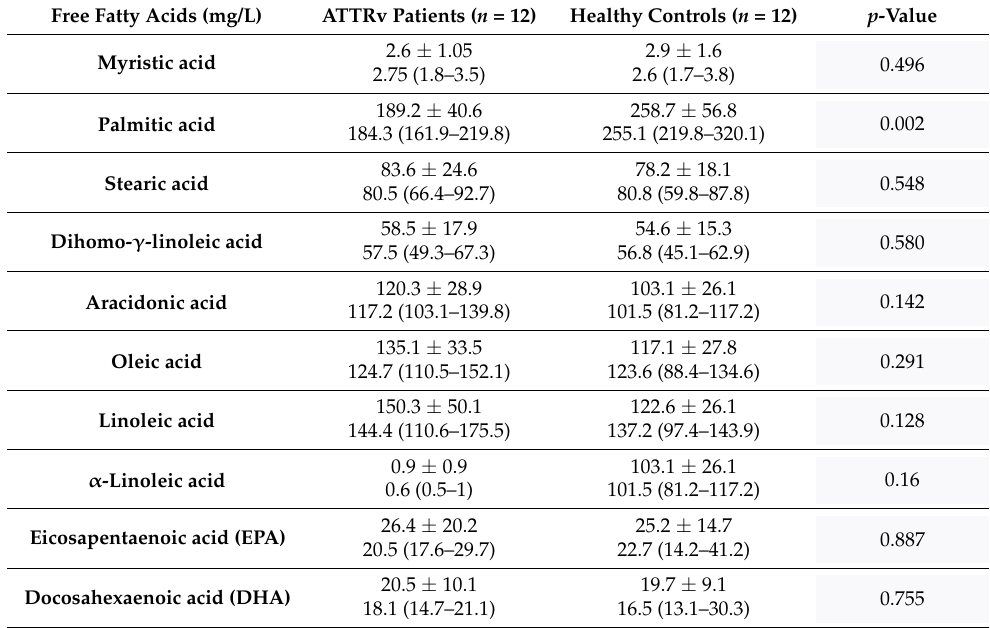
Table 2. Comparison of free fatty acids levels in ATTRv patients and in healthy controls, expressed as mean ± standard deviation (SD) and median and interquartile range (IQR). Bold values denote statistical significance at the p < 0.005 considering Bonferroni’s correction for multiple